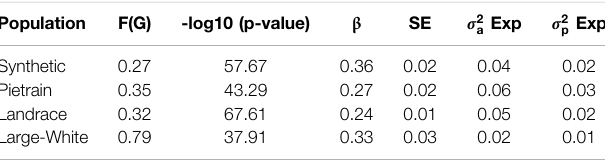
TABLE 4 | Description of the lead SNP (rs80985094) for backfat for each population. Population